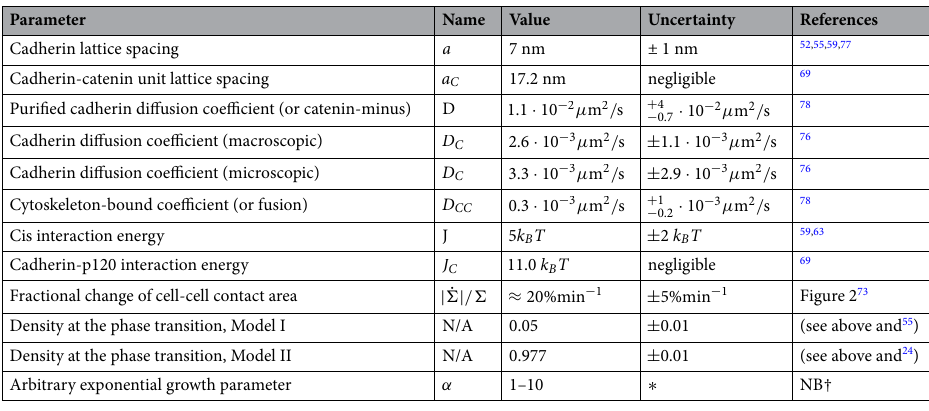
Table 1. Summary of the physiological values used in the model. Note the large standard deviation in the cadherin diffusion constants. This arises due to the different modes of cadherin movement 76 ; however, the uncertainty on the average value is much less than this standard deviation would suggest. We use the data from Figure 11 from Sako et al. 78 to estimate the asymmetrical uncertainties on D and D CC , and report the median value which seems more meaningful. For the diffusion rate of a cluster of 6 cadherins, we estimate the degree of reduction in D to be slightly less than an order of magnitude 79 . † NB: Depends on the tolerance on how far the coarsening has progressed. Here we choose a factor of e (ca. 63% growth), whereas simulations with a 1% tolerance 80 give a value of α closer to 10. It seems clear that cadherin clustering should become visible before coarsening